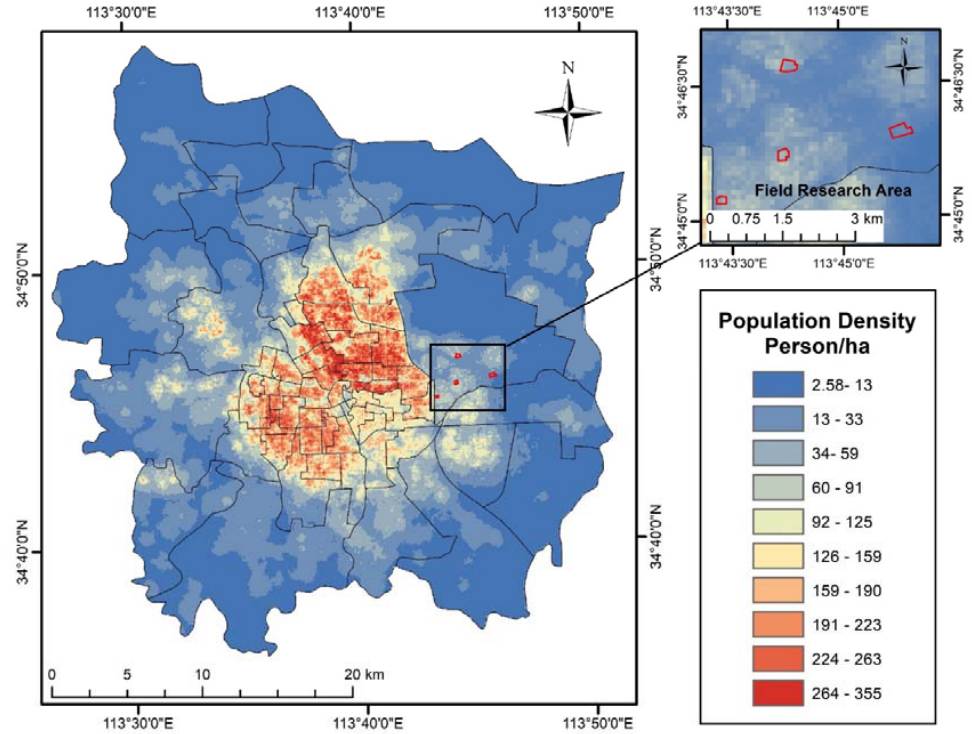
Figure 6. Overview of the gridded population distribution in Zhengzhou (the sampled communities are zoomed in).